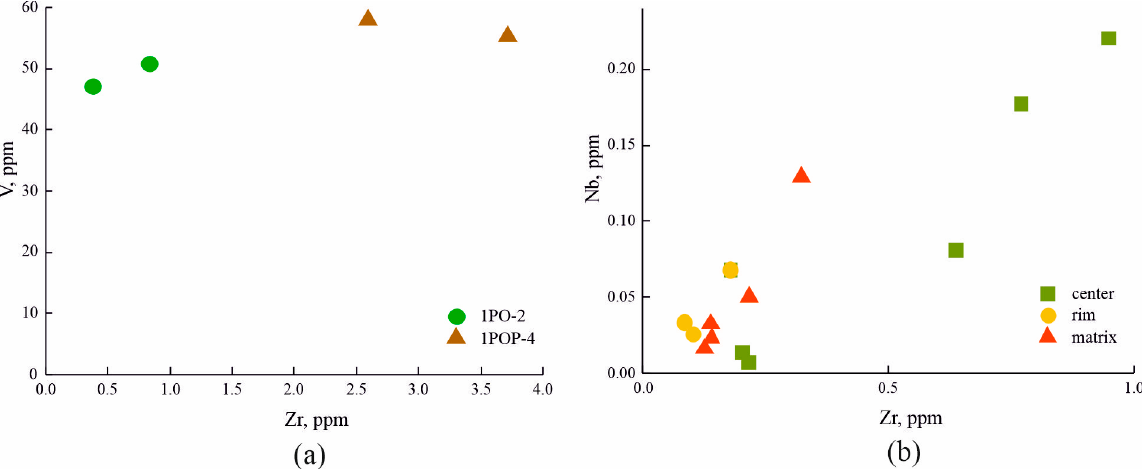
Figure 8. Trace element correlations (ppm) in chondrule pyroxene ( a ) and olivine ( b ) from the Kargapole meteorite.